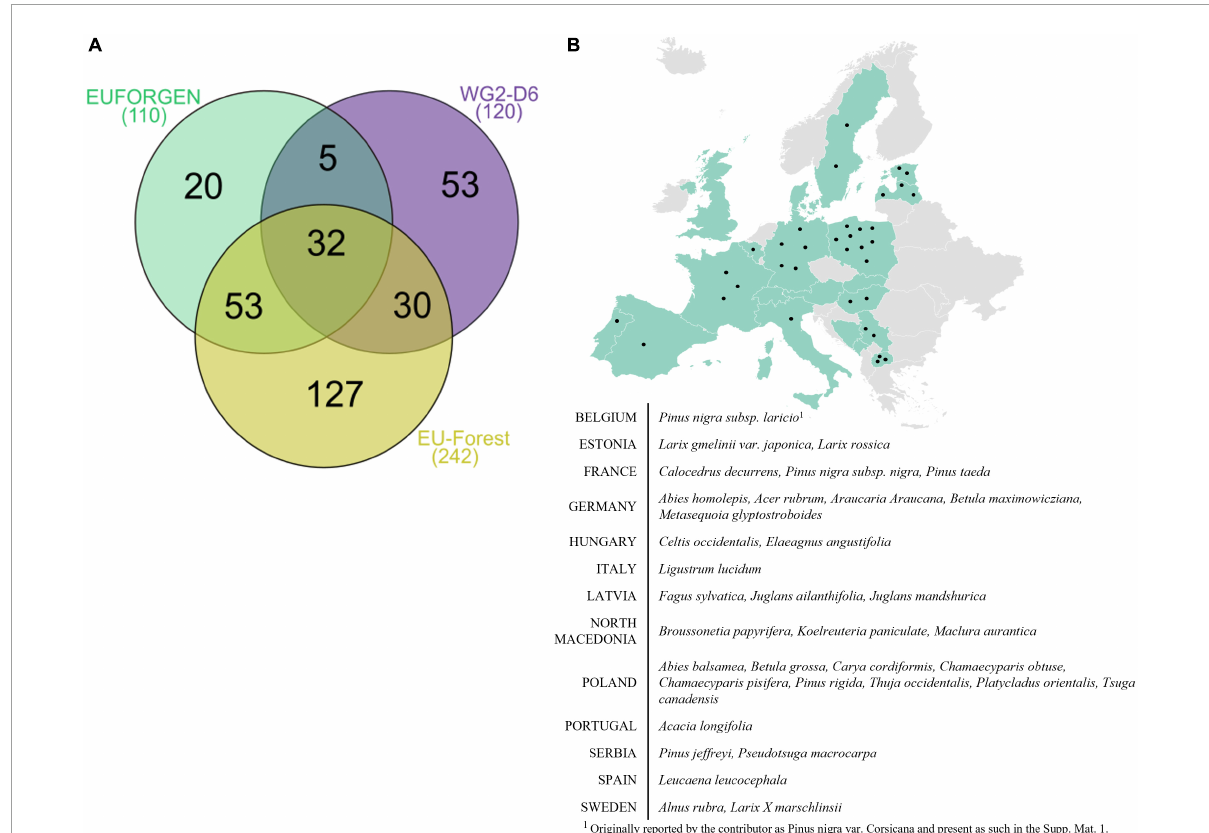
FIGURE5 (A) Venn diagram of species overlaps and differences between EUFORGEN, EU-Forest and WG2-D6 questionnaire. (B) The number of “less common” species reported by only one country (countries with symbols) in the WG2-D6 questionnaire. Countries colored in blue are the ones that participated in the